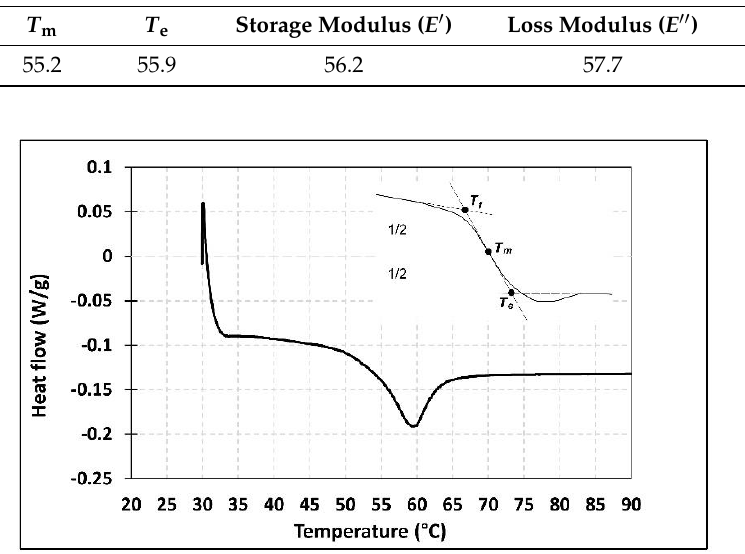
Figure 5. Differential scanning calorimetry (DSC) test results.